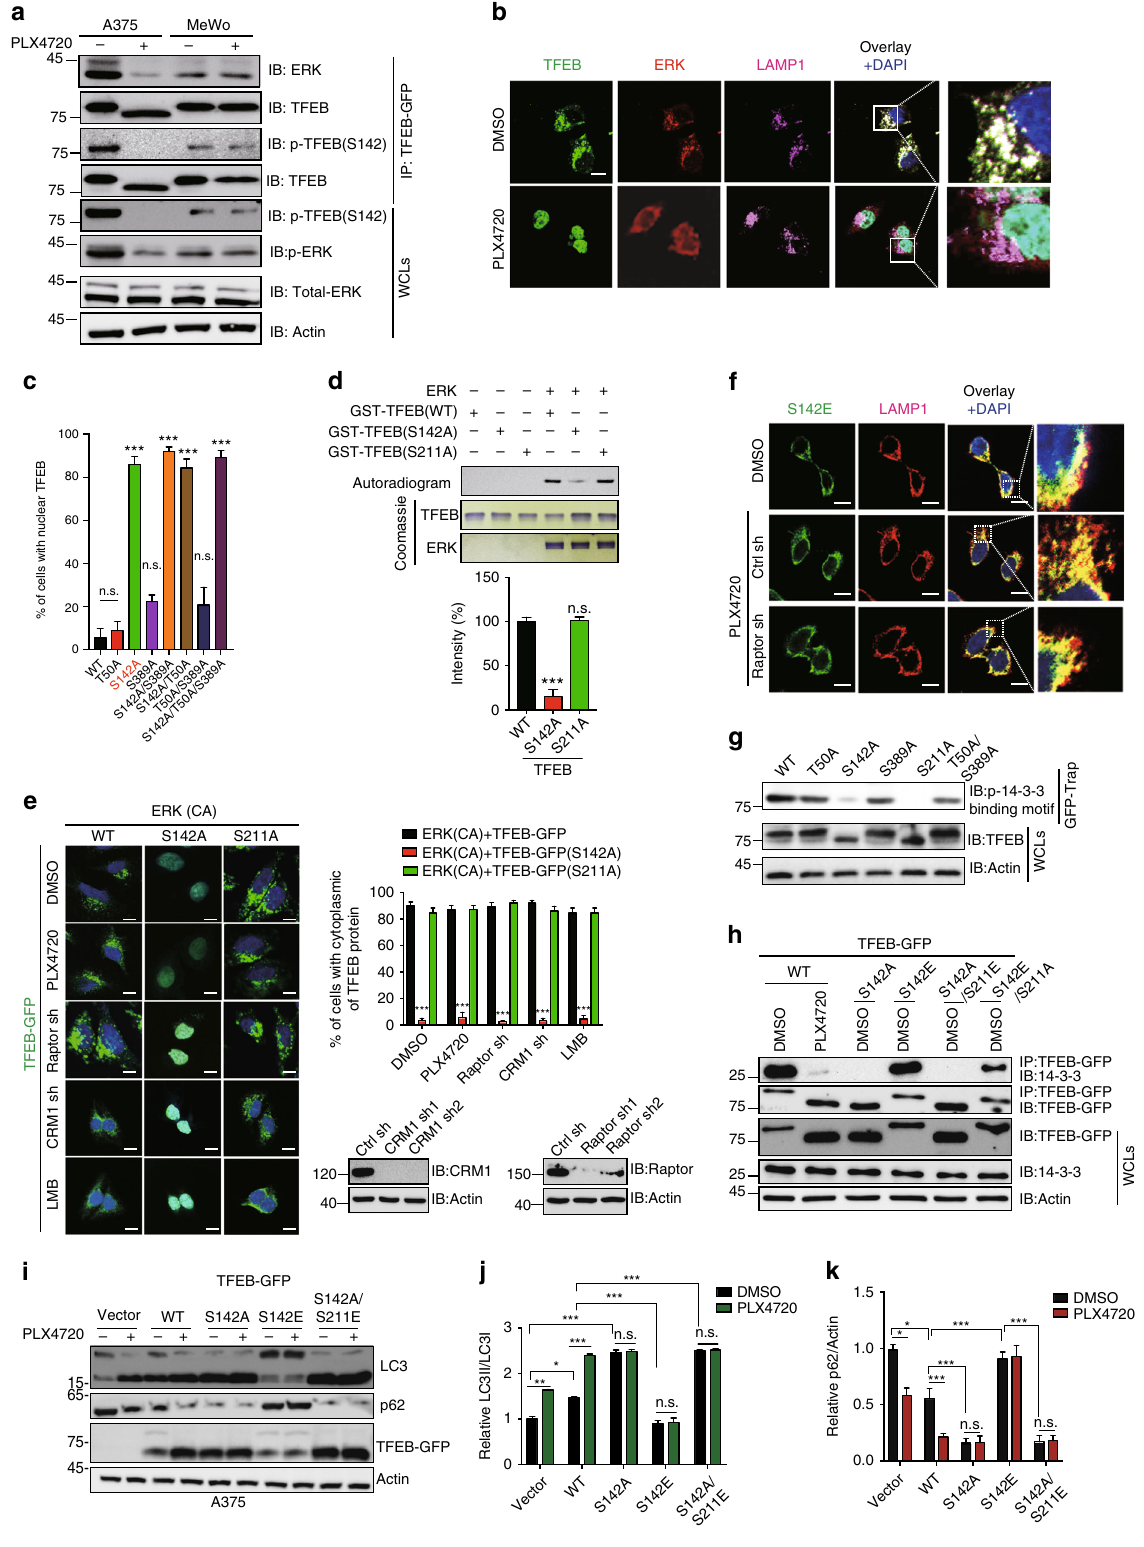
but downregulated by TFEB S142A , were related to EMT (Sup- plementary Fig. 6d and Supplementary Data 1c) and TGF- β target genes (Fig. 5h; Supplementary Fig. 6e; and Supplementary Data 1d – f). TGF- β signaling is a direct mediator of EMT, promoting expression of EMT-inducing transcription